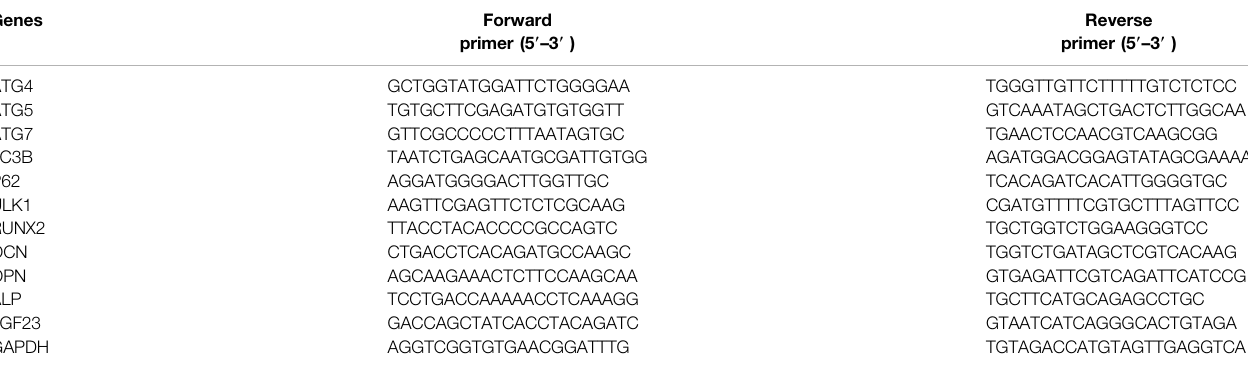
TABLE 1 | The primer sequences used in this study are listed as follows. Genes